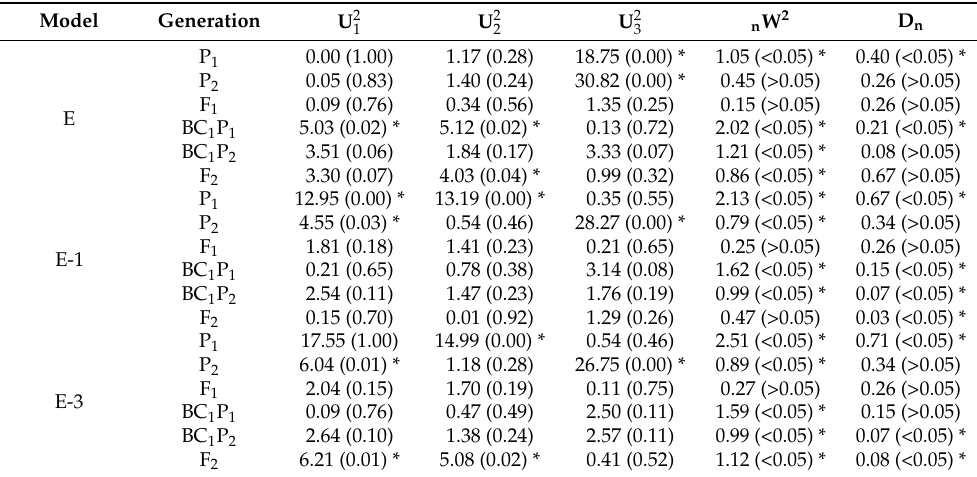
Table 4. Tests for goodness of fit model of CFW resistance in segregated